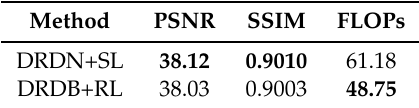
Table 4. Comparison of supervised learning and reinforcement learning on the RENOIR. Best performance is in